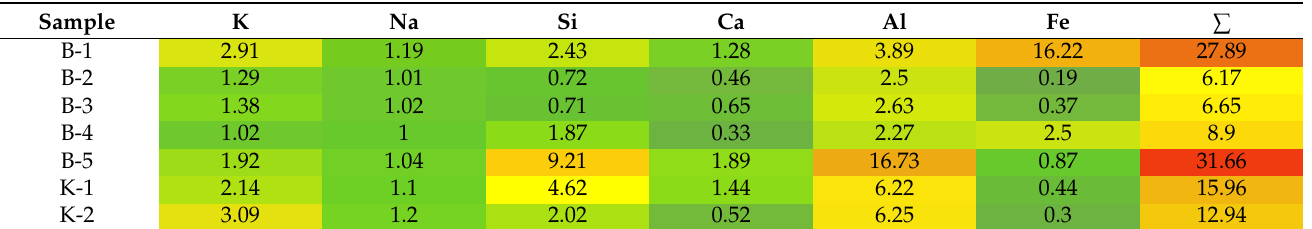
Table 8. The coefficients for elements bioleaching from clays after its stimulation with acetate and